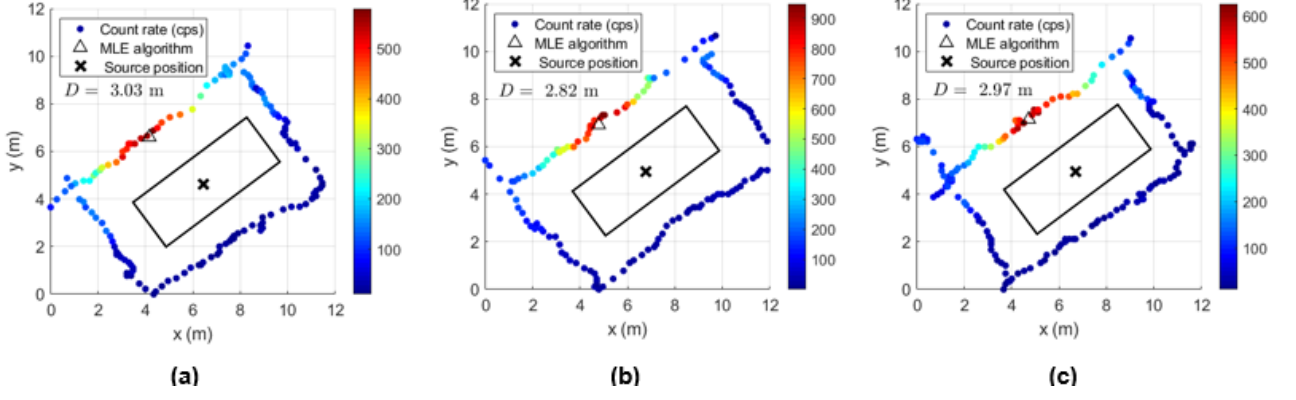
Figure 27. EJ-200 scintillator gamma-ray count rate (cps) measurements with detection system coupled with the drone considering the Troxler equipment oriented 90 ◦ (collimated 215 MBq 137 Cs source exposed—first notch after safe position) in the center of the shipping container. Distance “D” between the sources position and MLE calculated position is also given. Drone trajectories were performed at: ( a ) one-third the container height. ( b ) half the container height. ( c ) two-thirds the container